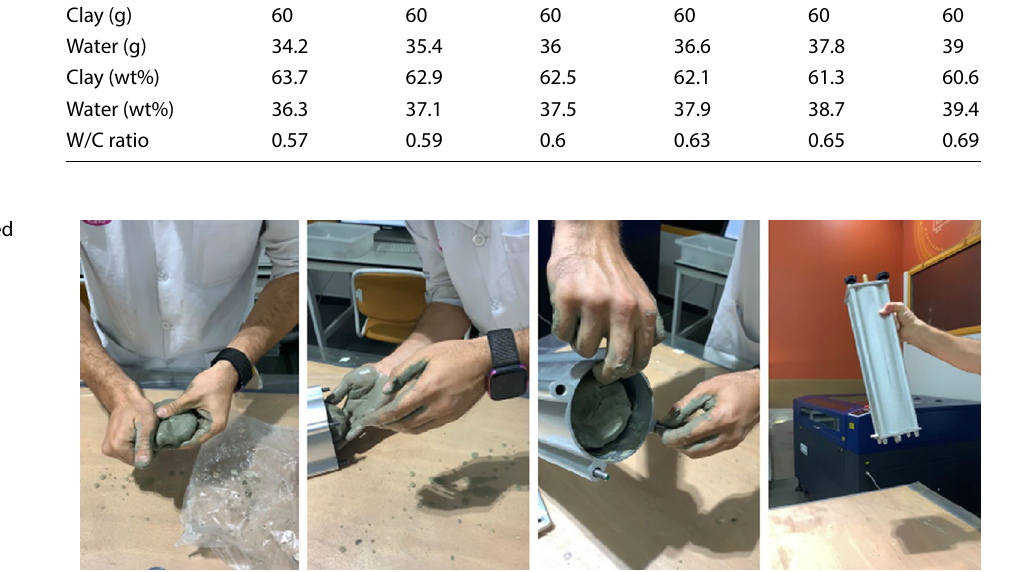
Table 2 Effective water/clay ratio